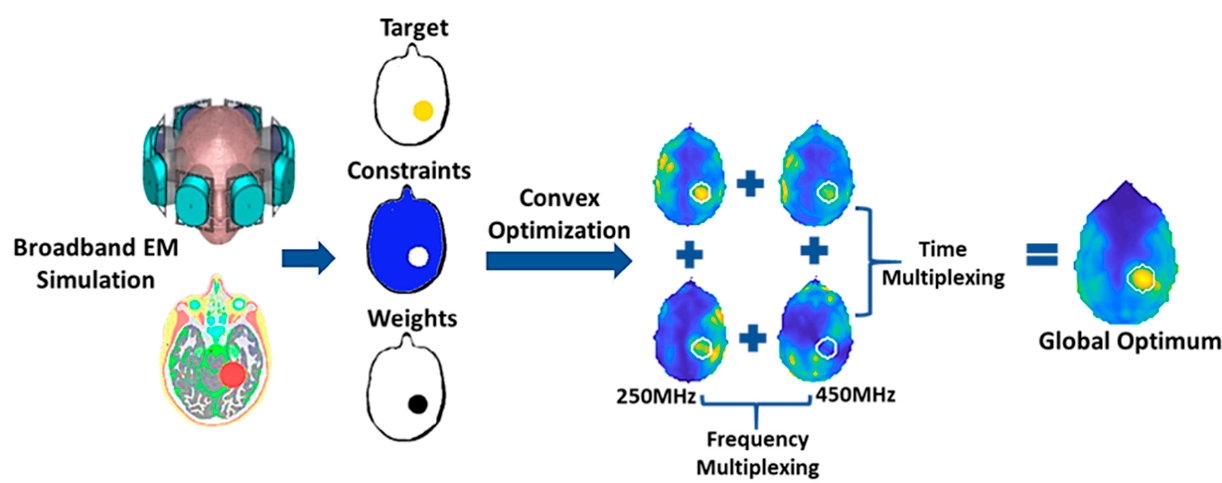
Figure 4. Multiplexed vector field shaping (MVFS) optimization [84]. The optimization process is a convex formulation of the time-frequency-multiplexed constrained RF heating problem, and provides an iterative algorithm to efficiently find its globally optimum solution. The MVFS algorithm provides globally optimal excitation vectors by defining the appropriate phase and amplitude settings for each RF channel of the ThermalMR RF applicator, and automatically selects the appropriate intervention frequencies and time-interleaved excitations to match the constructive interference pattern to best deliver RF power at the desired target location and shape. The resulting SAR distribution of the incident E-field interference is tailored to focus heating of the target volume while minimizing local peak RF exposure to healthy tissue below a safe threshold. If M individual excitation modes belong to the same excitation frequency, then time multiplexing is done with each solution vector scaled by √ M, and the excitations were played out sequentially [84]. Excitations at different frequencies can be played out concurrently as their electromagnetic fields do not interact coherently [84]. The final resultant target shape is created by superimposing these individual patterns for each